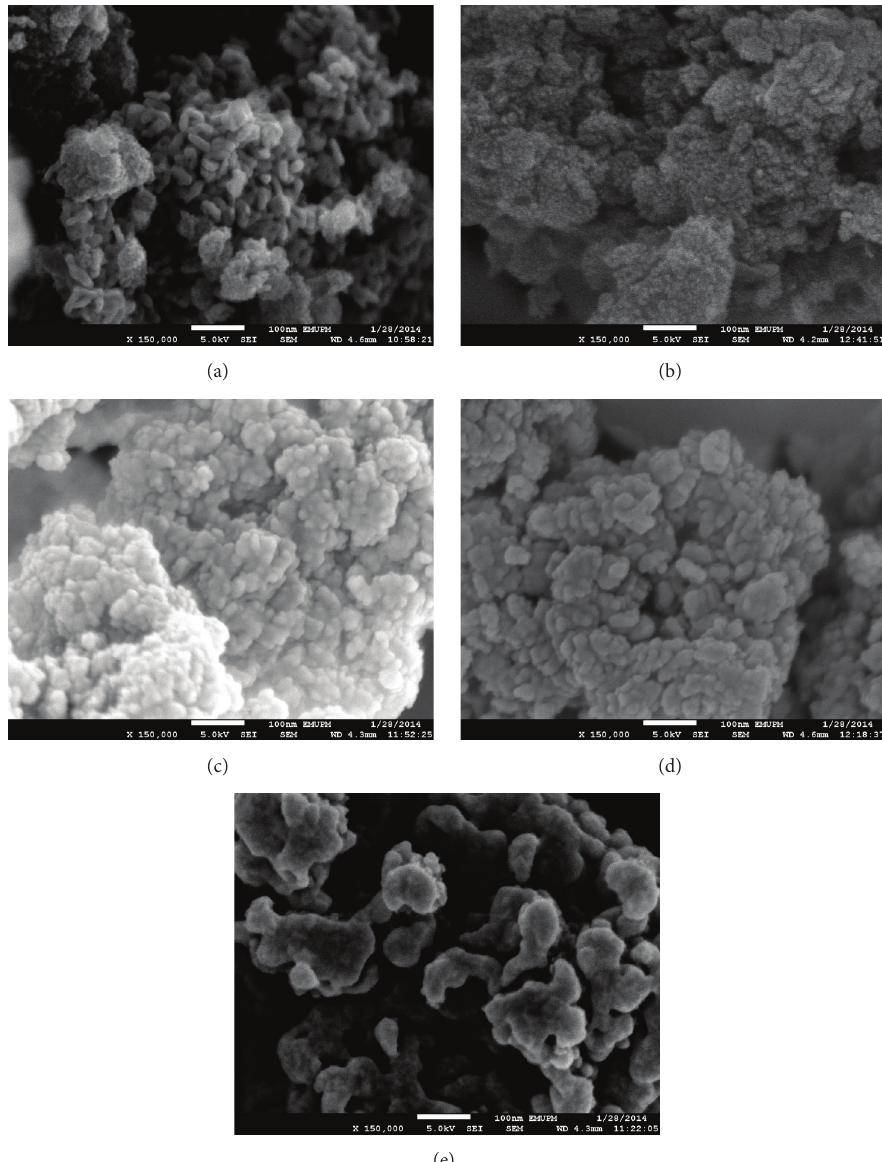
Figure 2: FESEM images of (a) TiO 2 particles, (b) TCd1, (c) TCd2, (d) TCd3, and (e) TCd4 nanocomposites taken at 150K magnification and 5.0 kV SEI signal. Scale bar